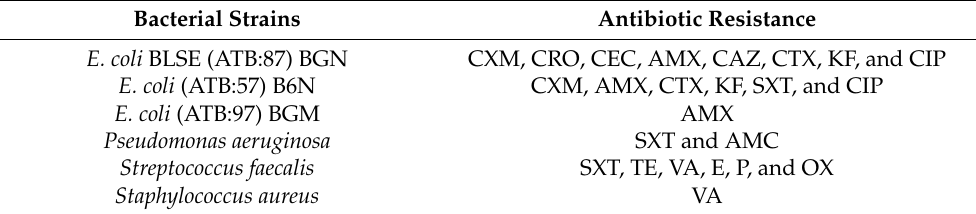
Table 6. List of antibiotic resistance applied to the studied